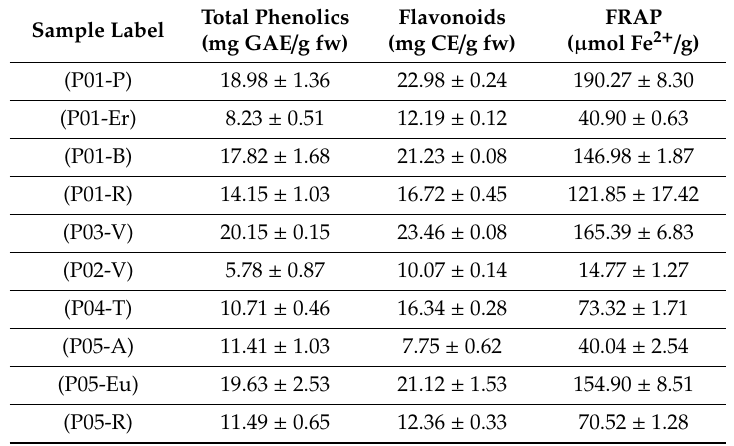
Table 2. Total phenolics, flavonoids, and ferric reducing antioxidant power (FRAP) assay results of bee pollen ethanol extracts. Data are expressed as mean ± standard deviation (SD) of three determinations. Sample